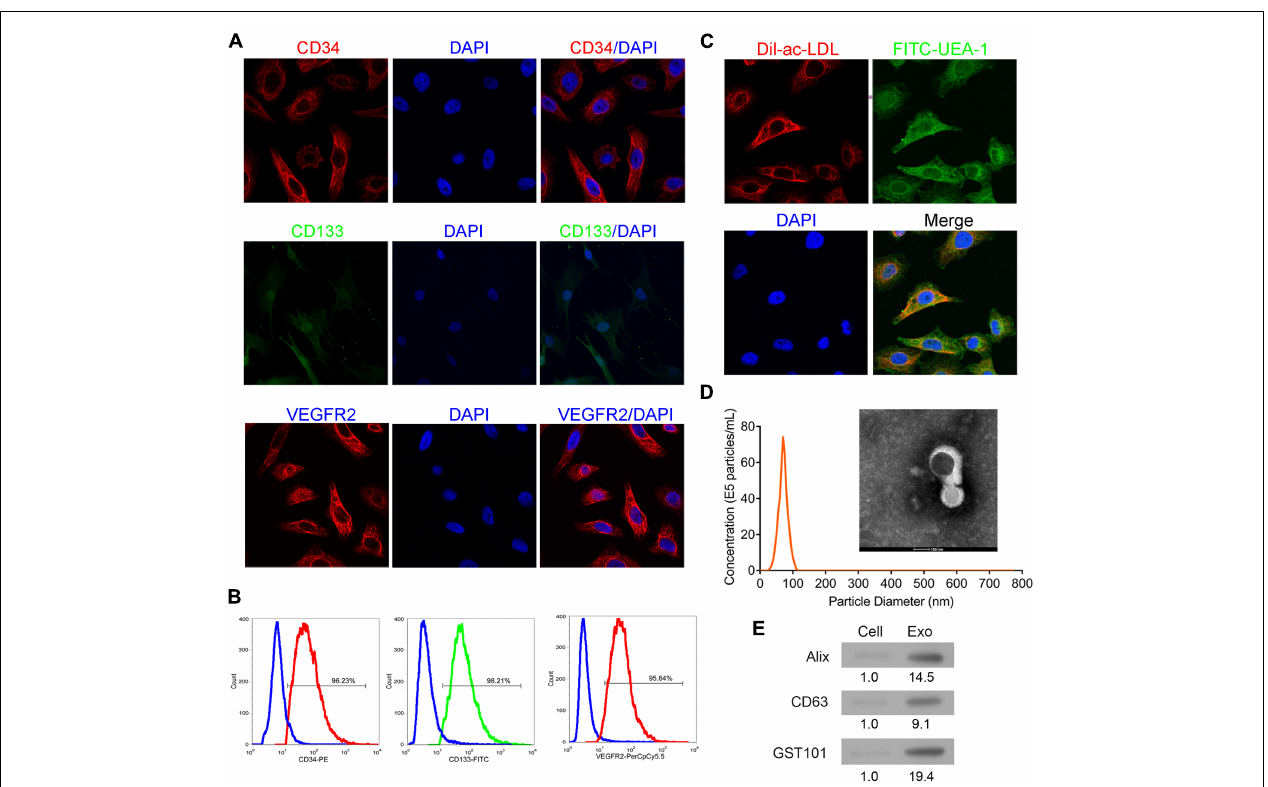
FIGURE 1 | Identification of EPCs from human peripheral blood and exosomes from EPCs. The isolated cells were cultured and then collected for detection of CD34, CD133, and VEGFR2 expressions by immunofluorescence staining (A) and flow cytometry (B) . Additionally, the phagocytic ability of the cells was examined by dual immuno-staining of Dil-Ac-LDL and FITC-UEA-1 (C) . The morphology, size, and concentration of the isolated exosomes were identified by transmission electron microscope and Nanosight tracking analysis, scale bar = 100 nm (D) . The expressions of exosome-associated proteins, including Alix, CD63, and TSG101 were detected by western blot (E) . EPCs, endothelial progenitor cells. N =